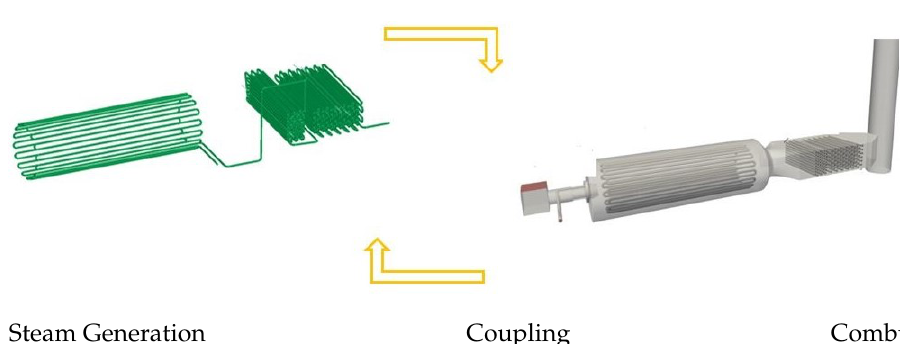
Figure 4. Degree of coupling between combustion and steam